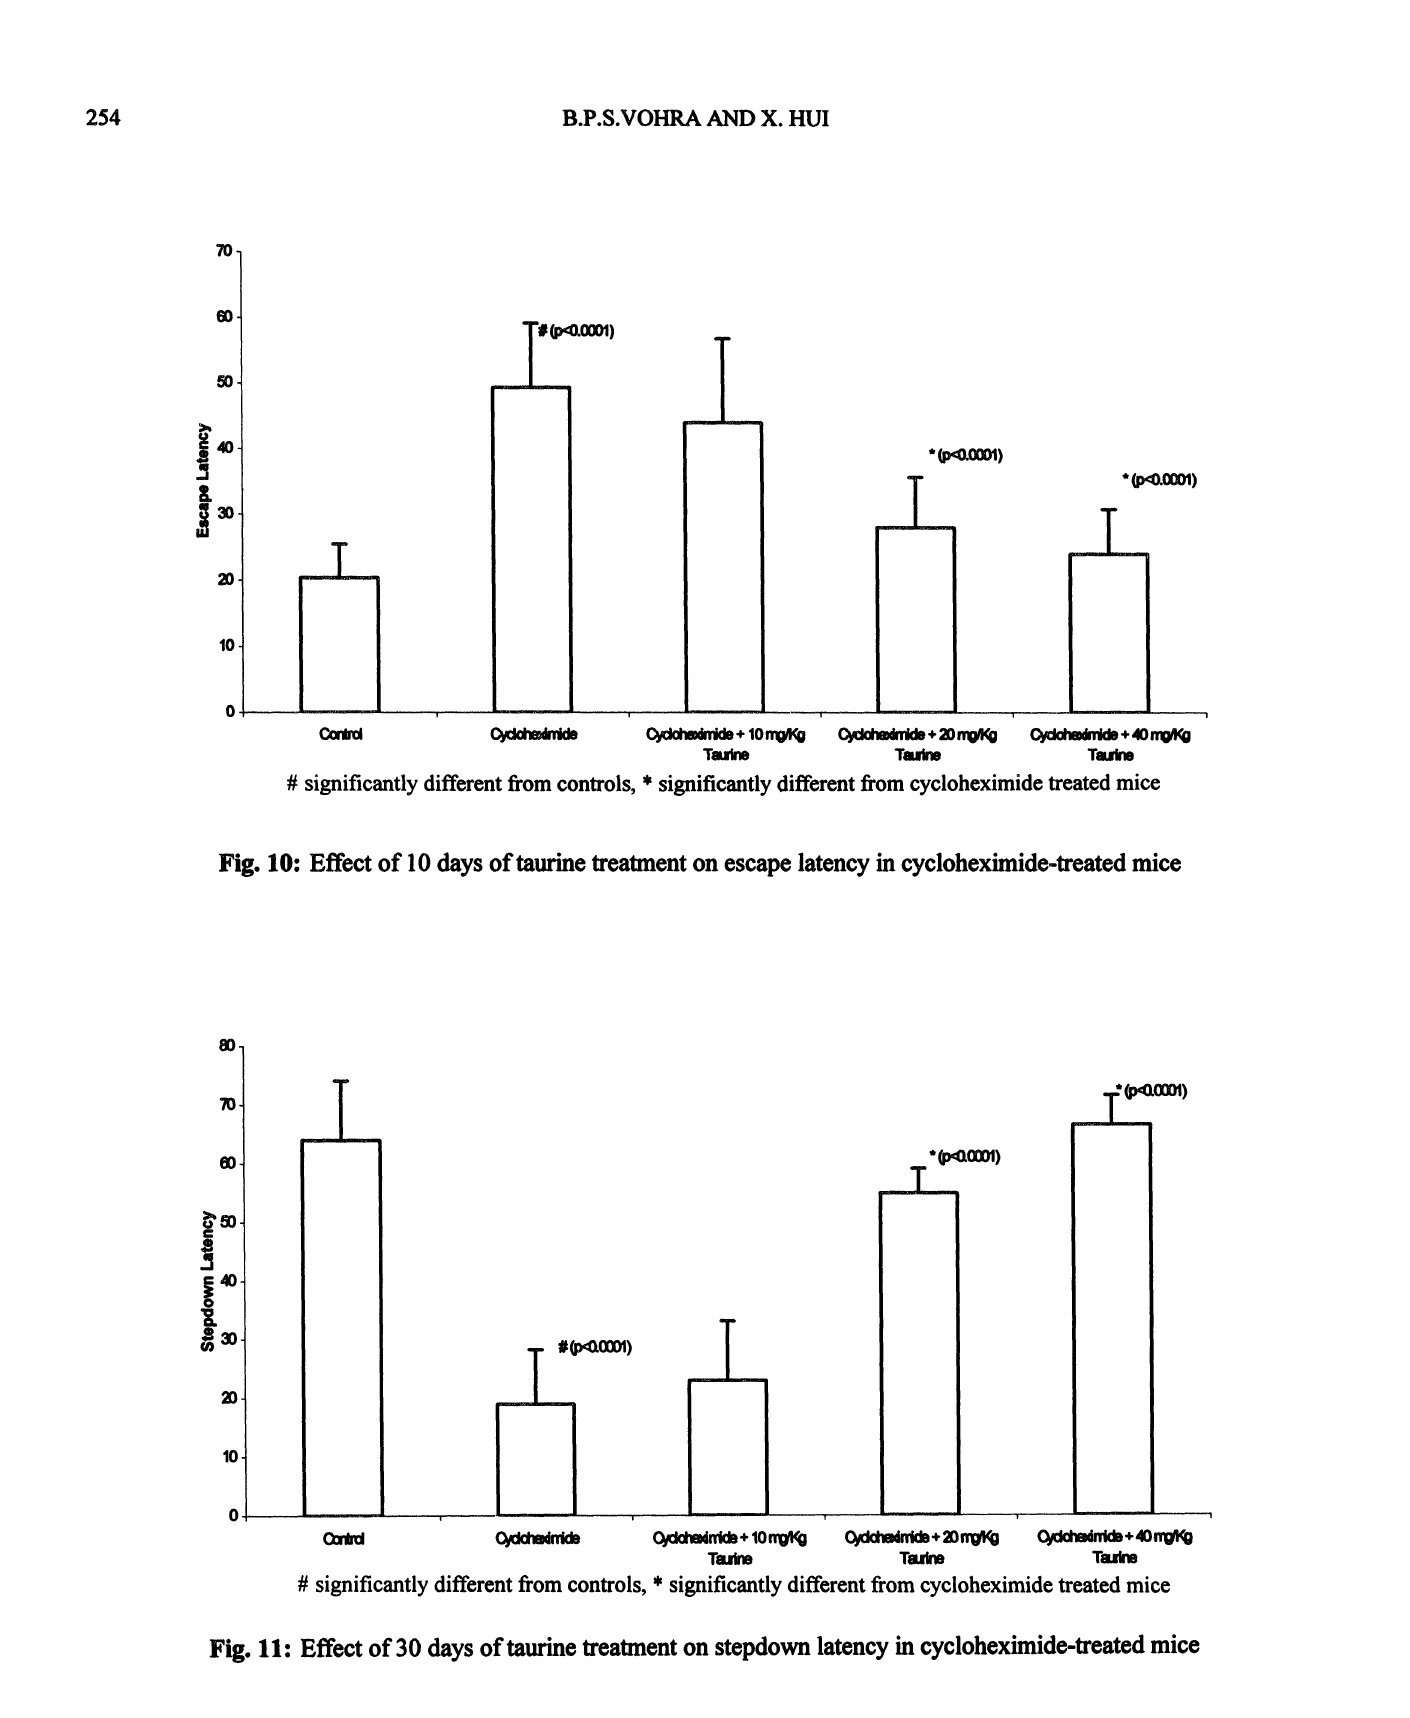
Fig. 11: Effect of 30 days oftaurine treatment on stepdown latency in cycloheximide-treated